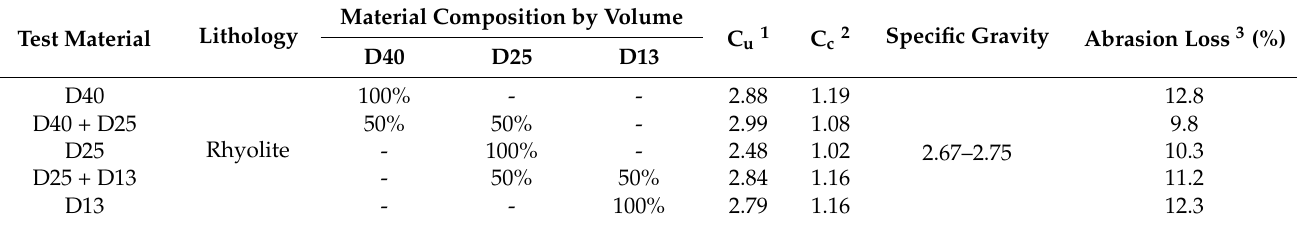
Table 1. Basic information of the test materials